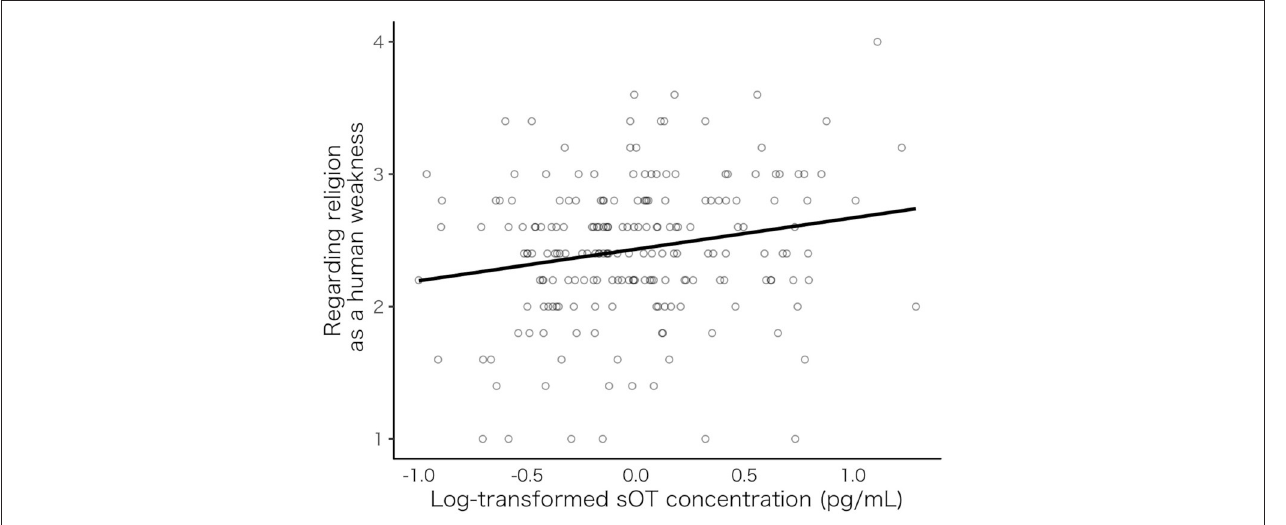
FIGURE 1 | Scatterplot showing sOT levels and faith (age and sex were controlled). Relationship between sOT level and a subscale of religious faith: regarding religion as a human weakness. sOT, salivary oxytocin.